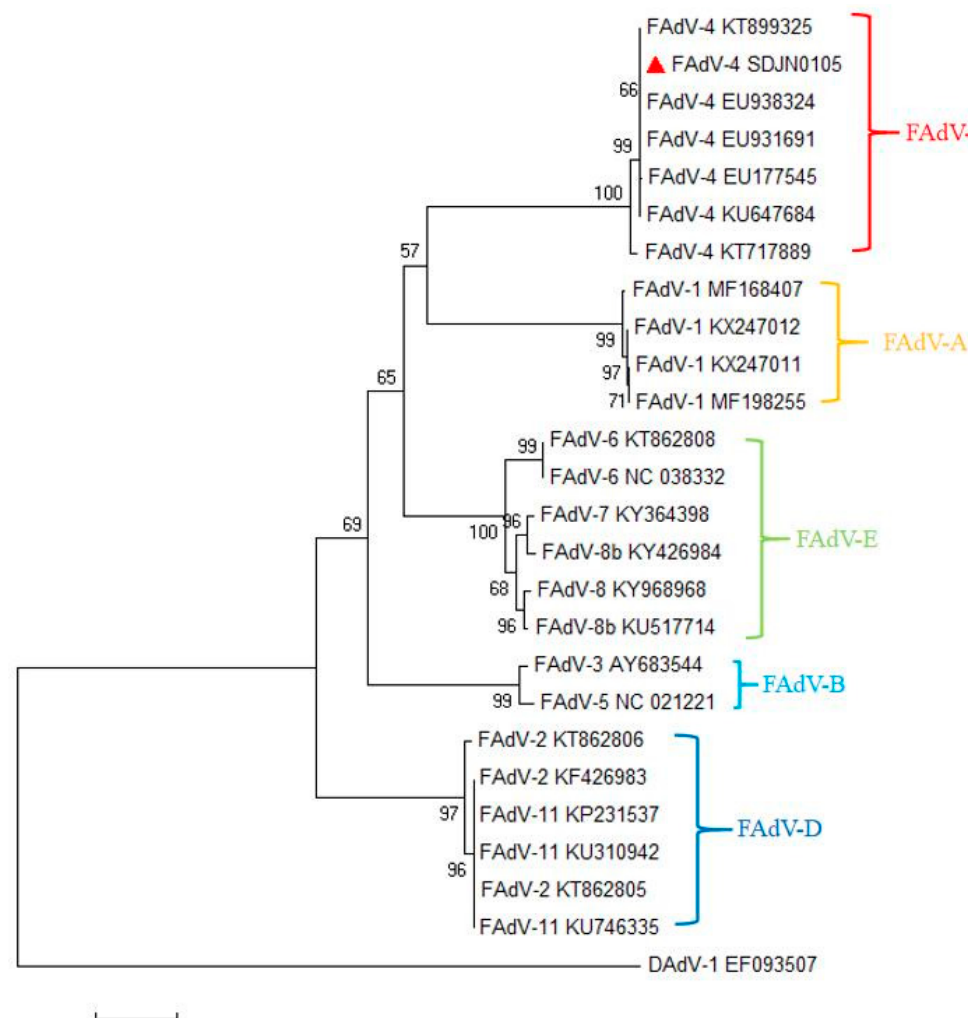
Figure 2. Phylogenetic tree of the isolated FAdV-4 strain (SDJN0105) based on the L1 loop of hexon gene sequences. The SDJN0105 sequenced in this figure is marked with a red triangle; other FAdV strains and DAdV strain used in this study were found on the National Center for Biotechnology website. GenBank numbers are shown in Table 2. This phylogenetic tree was generated using MEGA 6.0 software employing the neighbor-joining method and a 1000-bootstrap analysis. The scale